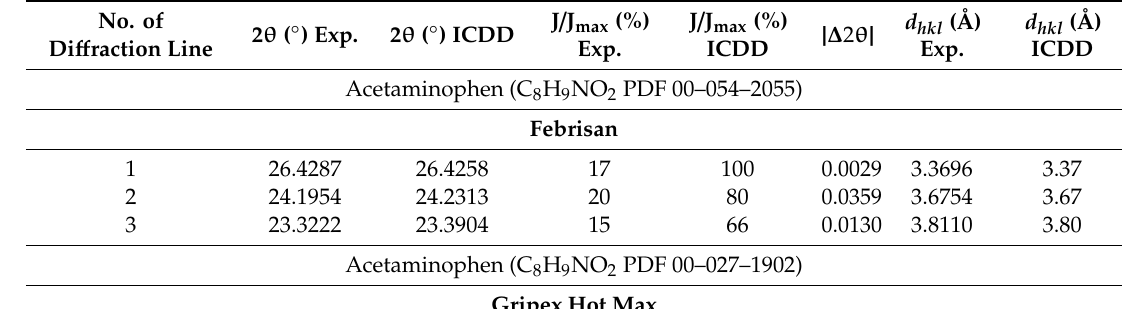
Table 6. Comparison of experimental data with data from the ICDD database for the drugs Febrisan, Gripex Hot Max, and